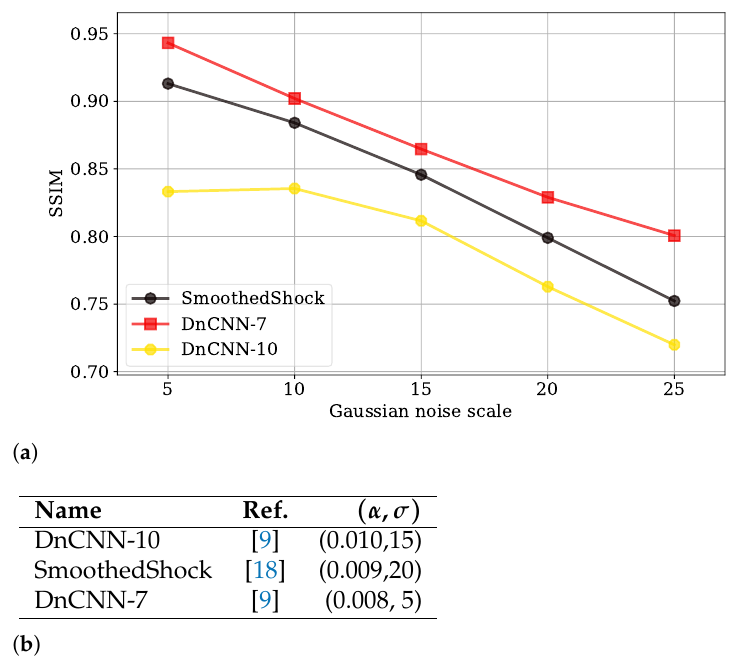
Figure 6. Evaluation of ( α , σ ) -robustness, by the graphical ( a ) and numerical ( b ) approaches, for the smoothed shock filtering and the DnCNN network, learned with two